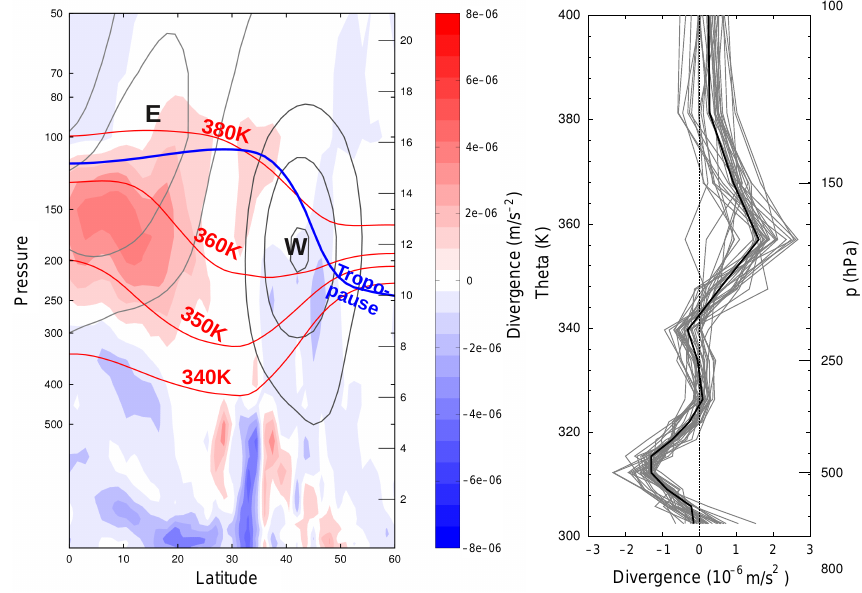
Figure 1. Left panel: mean JJA 2006 divergence over 20–120 ◦ E overlaid with mean zonal winds (light gray: negative; dark gray: positive; contour interval at 10ms − 1 ). Right panel: mean profile of divergence in theta coordinates averaged over 20–120 ◦ E and 0–30 ◦ N (thick solid black line) and daily profiles (thin gray